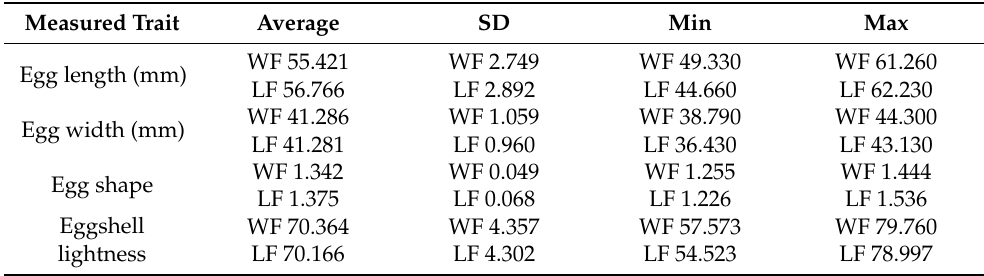
Table 2. The length, width, shape, and eggshell lightness of Capercaillie eggs collected from Wisła Forestry (WF) ( n = 59) and Le˙zajsk Forestry (LF) ( n =